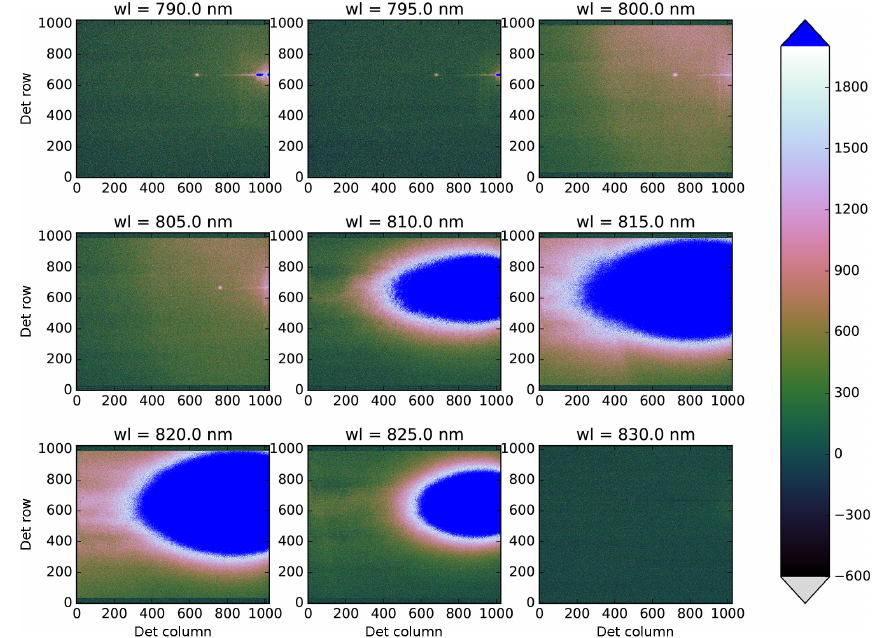
Figure 26. The straylight image of the NIR detector for a range of laser wavelengths λ laser on the red side for fibre 4 before normalization. Detector columns are in the spectral direction, and detector rows are in the spatial direction. The colour scale is the same for all images.